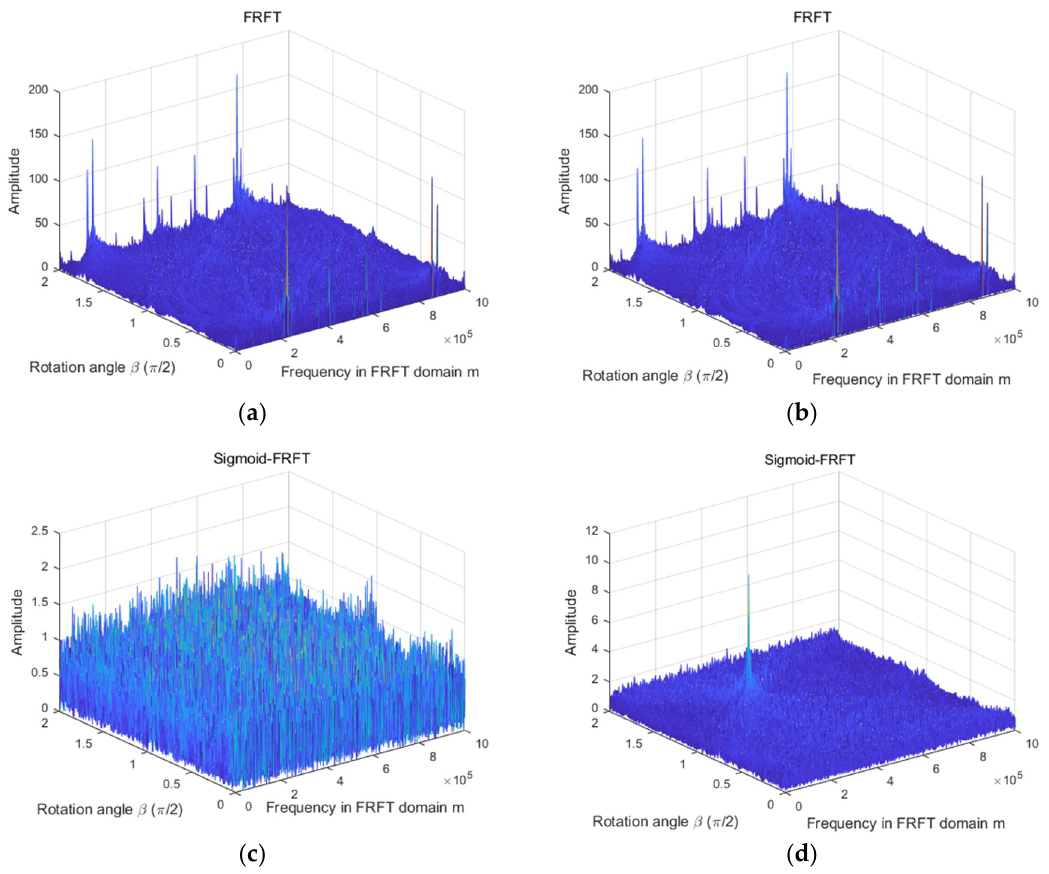
Figure 1. Time-frequency distribution of the fractional Fourier transform (FRFT) and Sigmoid-FRFT in an impulsive noise environment. ( a ) FRFT of the impulsive noise; ( b ) FRFT of the linear frequency modulation (LFM) signal with impulsive noise; ( c ) Sigmoid-FRFT of the impulsive noise; ( d ) Sigmoid-FRFT of the LFM signal with impulsive